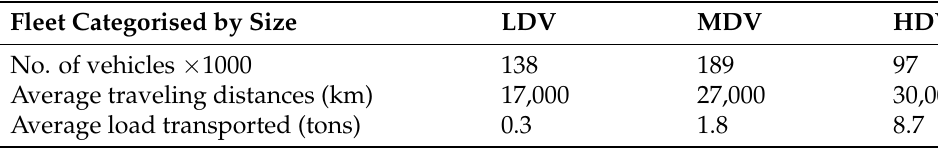
Table 3. Freight Transport Characteristics.